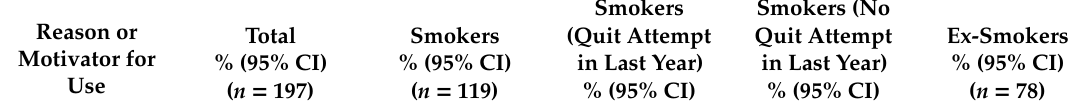
Table 4. Most commonly cited reasons and motivators for e-cigarette use among current (at least monthly) e-cigarette users in Wave 2 stratified by smoking